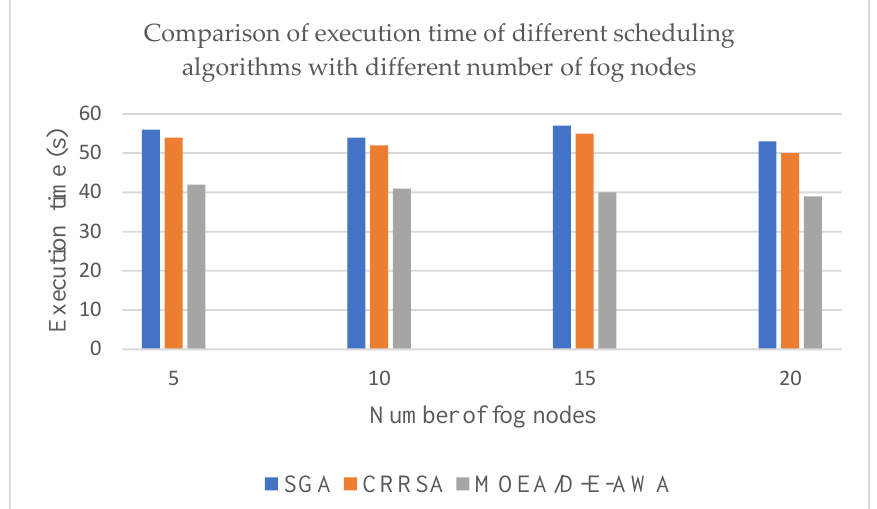
Figure 5. Comparison of total execution time.